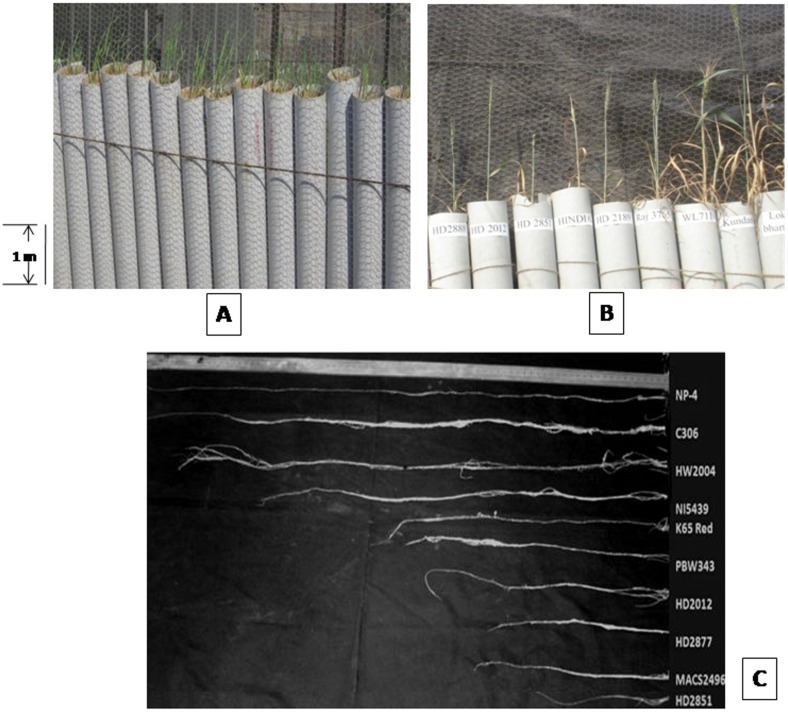
Root traits of 31 wheat genotypes studied under drought stress condition at reproductive stage.Wheat genotypes at seedling (A)and Maturity (B) stage grown in PVC pipes to examine root growth and development; (C) Representative picture showing variation in maximum root length of ten wheat genotypes grown in PVC pipes under drought stress conditions.